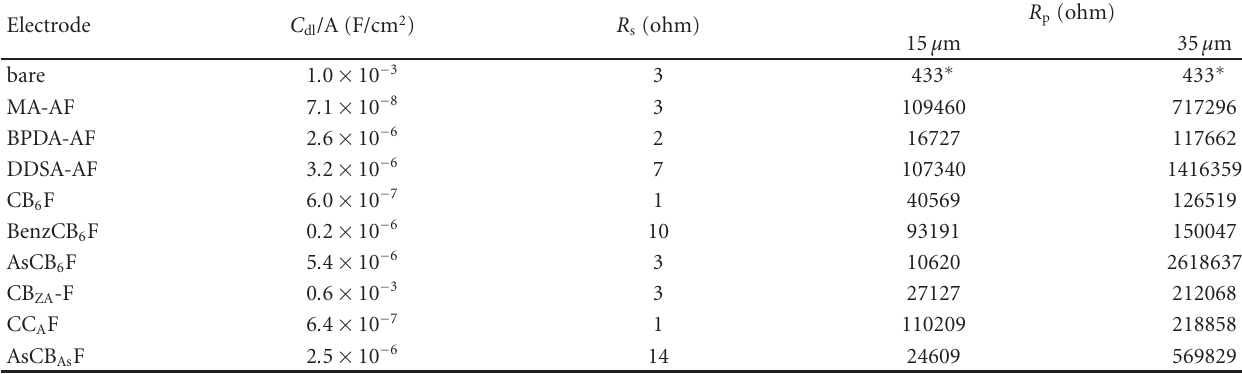
Table 1: Impedance parameters of bare and resin-coated SS in 1N H 2 SO 4 .